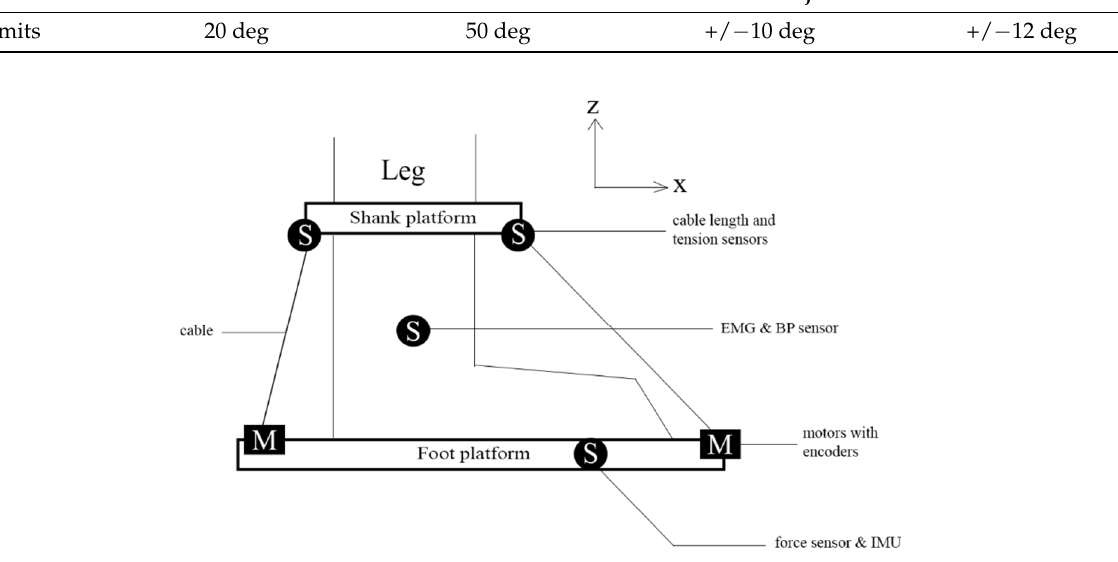
Figure 1. Conceptual design of CABLEankle.